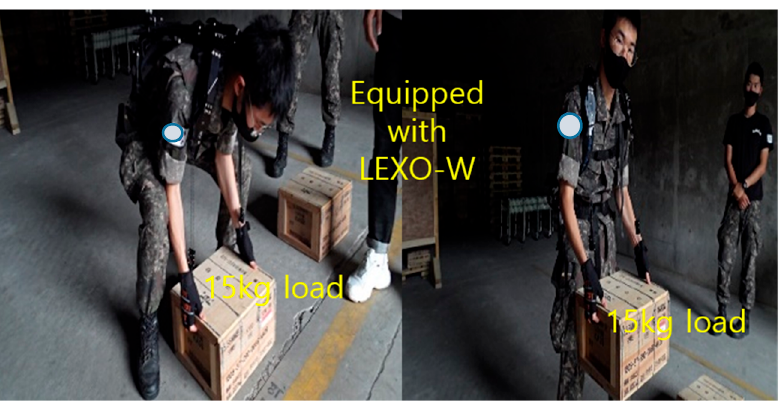
Figure 4. Equipped with the LEXO-W with a 15 kg load.